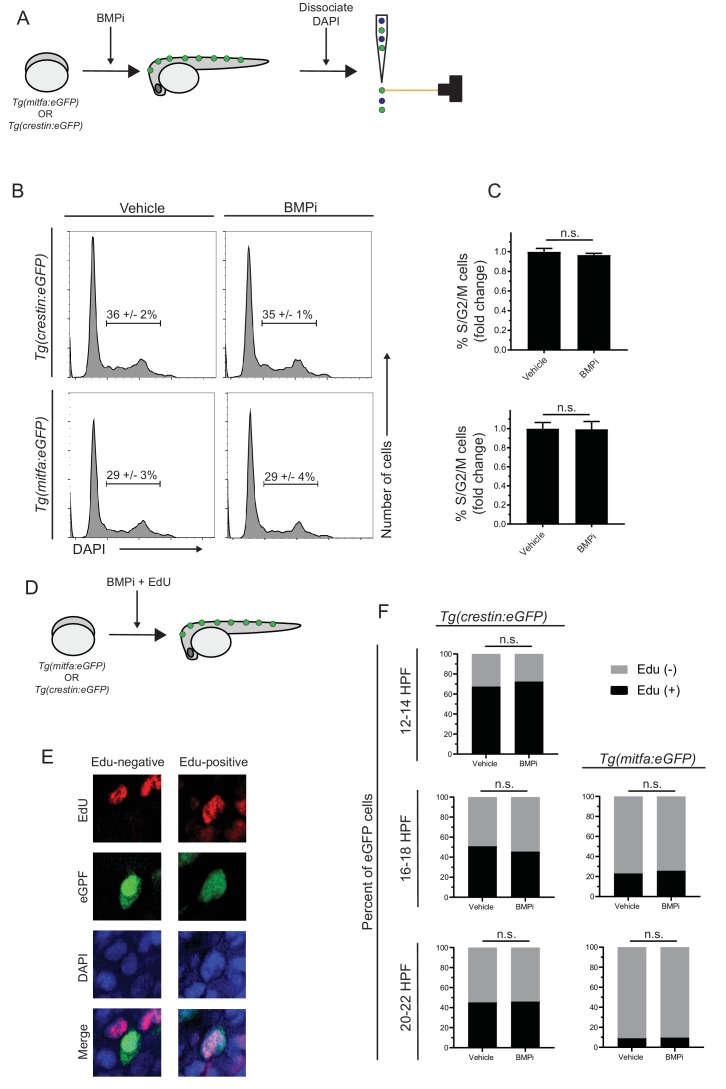
Increased proliferation is not observed in neural crest and pigment progenitor cell populations of BMPi-treated embryos.(A) Diagram of experiment. Embryos expressing either Tg(mitfa:eGFP) or Tg(crestin:eGFP) were treated with BMP inhibitor from 12 to 24 HPF. Following treatment, embryos were dissociated, fixed, and stained for DNA content using DAPI and analyzed via flow cytometry. Scale bar = 200 µm. (B) Flow cytometry histograms showing the percentage of cells in S/G2/M phases in crestin:eGFP-positive or Tg(mitfa:eGFP-positive cell populations in BMPi-treated embryos compared to vehicle-treated embryos. (C) Fold change of crestin:eGFP-positive cells (top) and mitfa:eGFP-positive cells (bottom) in S/G2/M phases. n = 3 biological replicates of 80–100 stage-matched embryos pooled for each condition. (D) Diagram of experiment. Embryos expressing either Tg(mitfa:eGFP) or Tg(crestin:eGFP) were treated with BMP inhibitor starting at 12 HPF. Embryos were concurrently treated with EdU from 12 to 14 HPF, 16–18 HPF, or 20–22 HPF. Following EdU treatment, embryos were fixed and assess for EdU incorporation. (E) Example image of EdU incorporation in eGFP-positive cells in vehicle- and BMPi-treated embryos. (F) Quantification of EdU incorporation in Tg(crestin:eGFP) and Tg(mitfa:eGFP) embryos at different time points, n = 62–166 eGFP-positive cells from two independent experiments (N = 2) for each condition and time point. Error bars represent mean + /- SEM, P-values were calculated using ratio paired t-test for panel C and Fisher’s exact test for panel F, n.s., not significant.